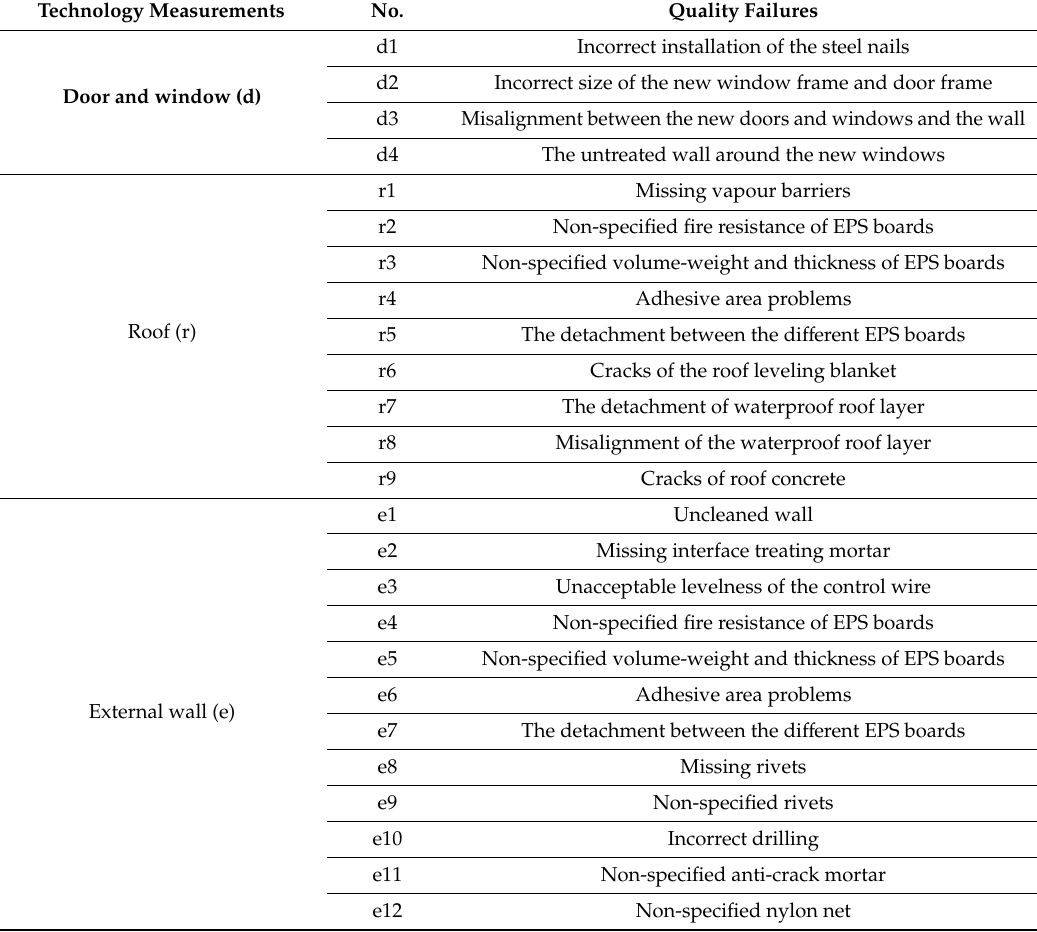
Table 5. The quality failures that occurred in renovation